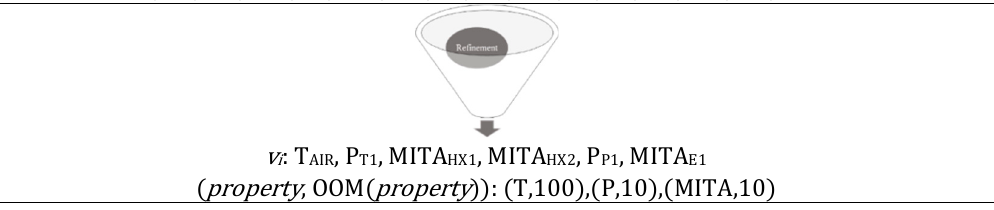
Figure 10. Main variables extraction.